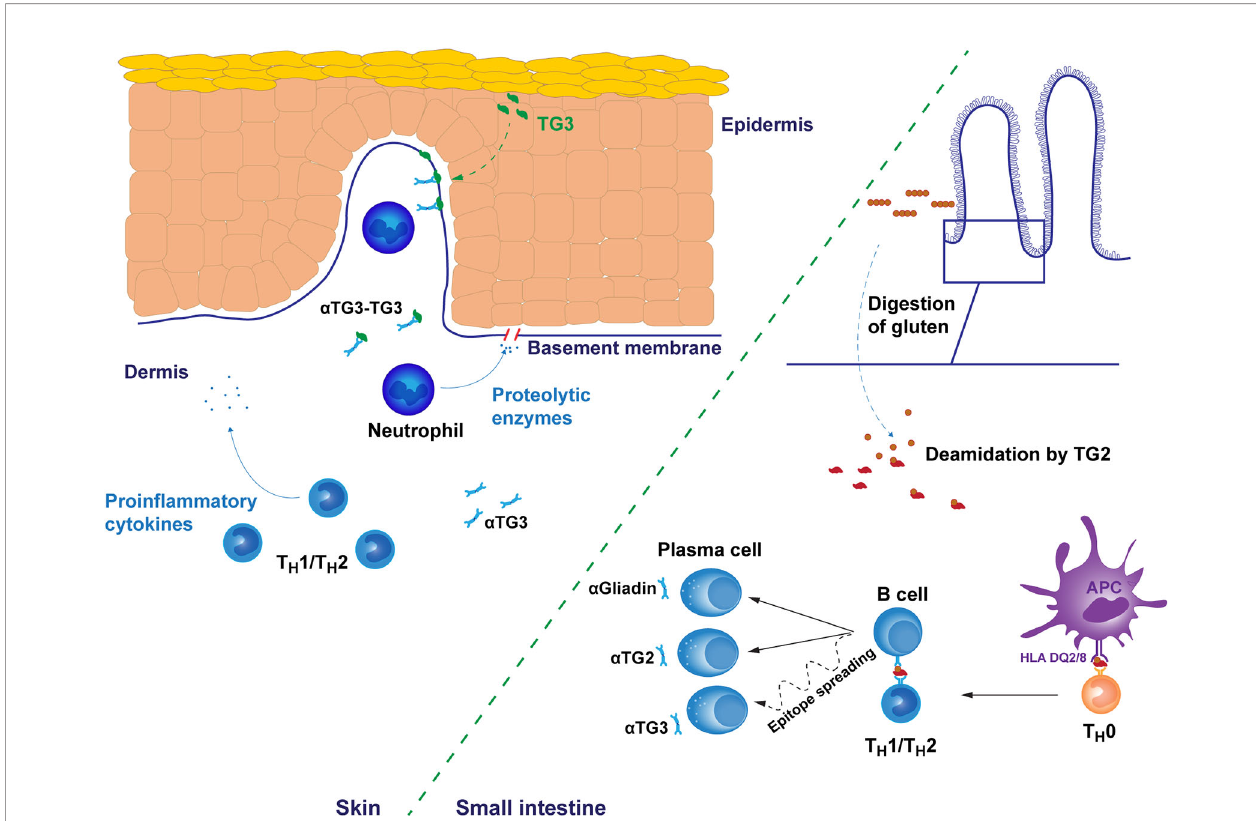
FIGURE 1 | Putative pathogenetic mechanisms of dermatitis herpetiformis. The early gluten-induced autoimmune response results in the production of autoantibodies targeting gluten-derived gliadin peptides and transglutaminase 2 (TG2) in the small bowel mucosa. Antibody speci fi city to transglutaminase 3 (TG3) may develop later by epitope spreading after initial autoreactivity against TG2. However, the dynamics of this processes are unknown. Immune responses are mediated by subtype 1 or 2 T helper cells. In the skin, IgA and TG3 form punctate structures, typically found in the dermal papillae. TG3 is endogenously produced in the upper layers of epidermis but may spontaneously diffuse towards dermis providing a possible explanation for the recruitment of autoantibodies into tissue bound immunocomplexes. Alternatively, IgA-TG3 immunocomplexes circulating free in dermatitis herpetiformis patient serum may bind to these sites. Tissue bound immunocomplexes attract neutrophil in fi ltration to dermal-epidermal junctions resulting in the cleavage of the basement membrane and fi nally in blister formation. The membrane cleavage is likely catalyzed by neutrophil secreted proteolytic enzymes targeting the fi brillar proteins of the basement membrane. a TG2/3, TG2/3 autoantibody, a Gliadin, anti-gliadin antibody, APC, antigen presenting